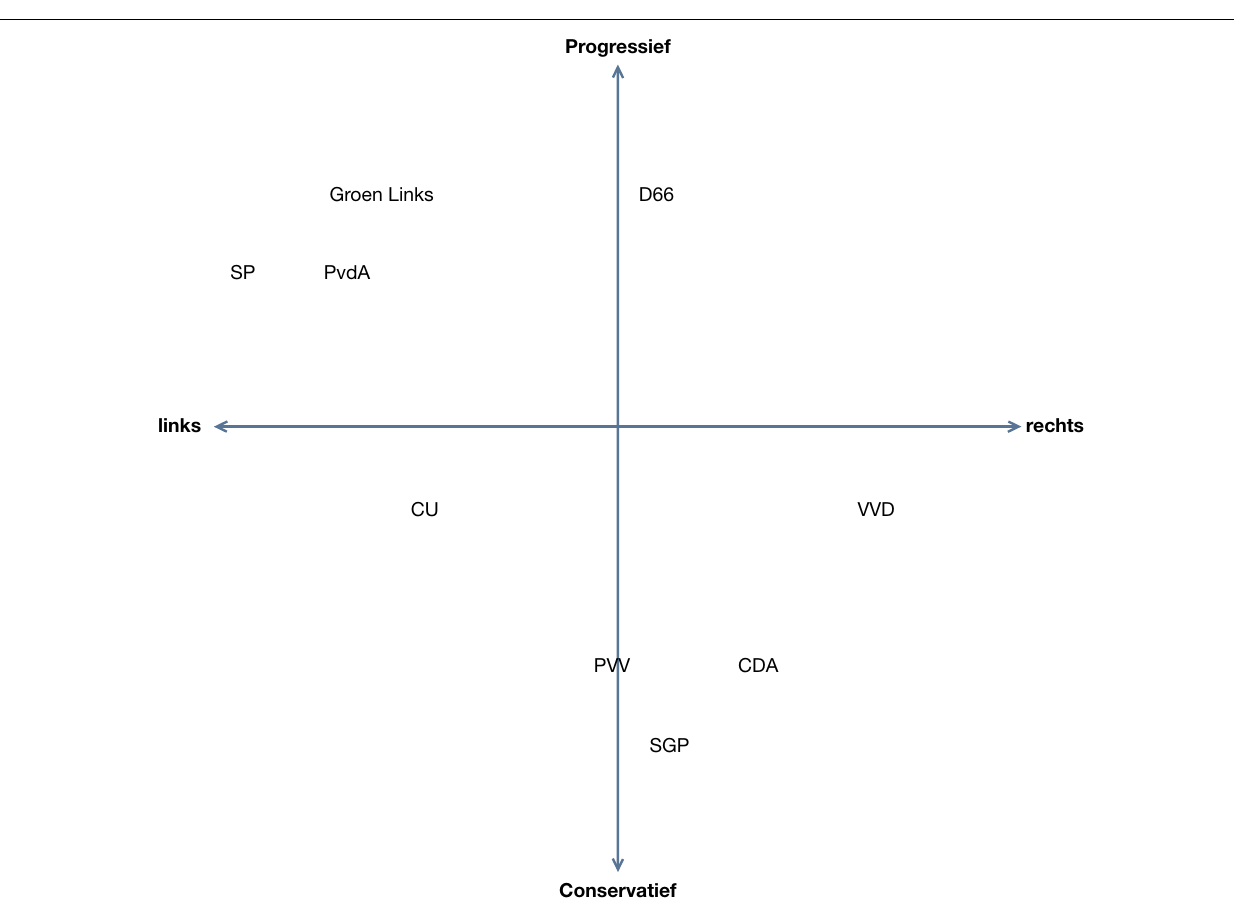
parties ( M = 5.97, SE = 0.18) than the current sample ( M = 4.57, SE =